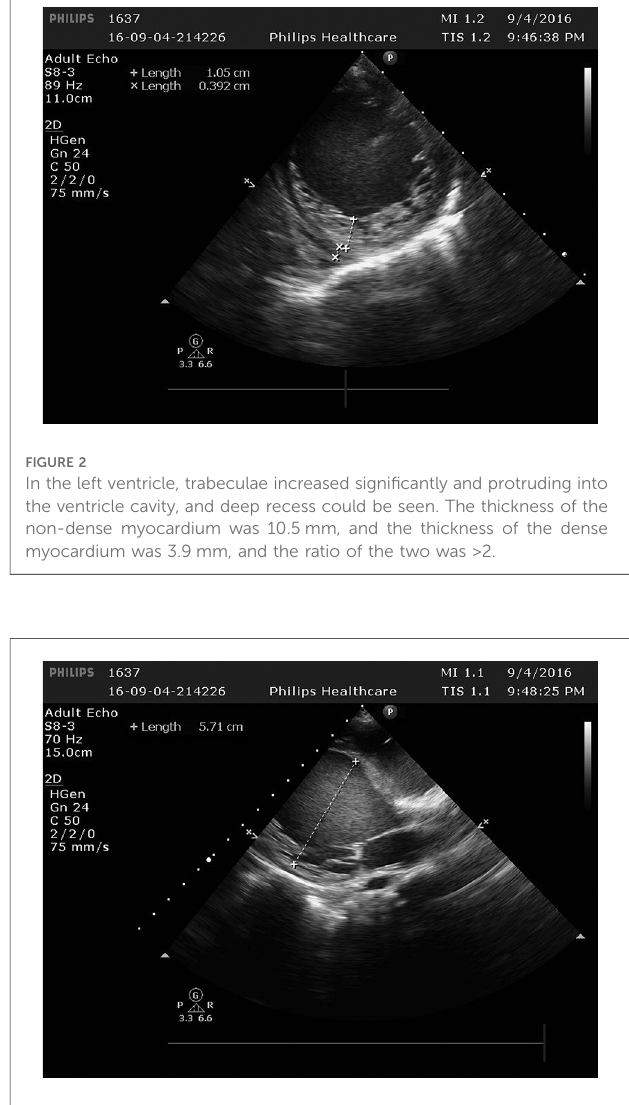
FIGURE 3 The left ventricle was signi fi cantly enlarged 5.71